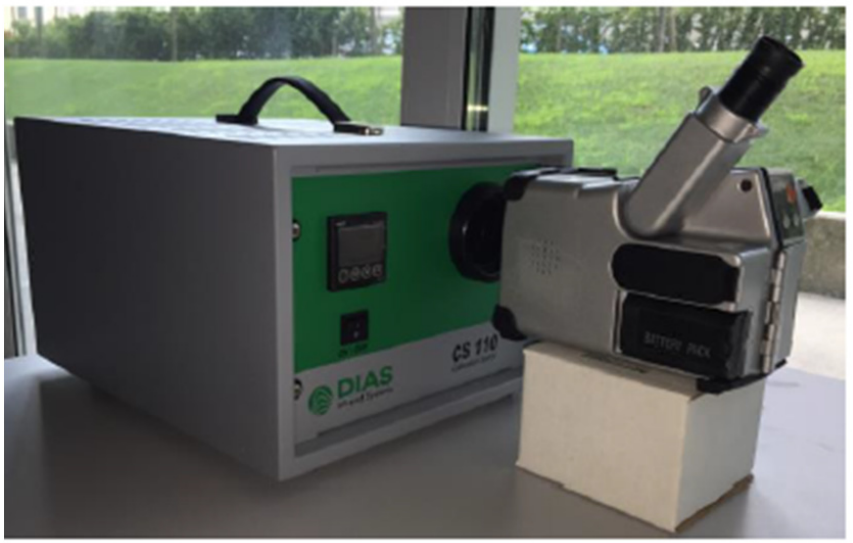
Figure 5. Calibration setup with relative positioning between the camera and the calibration body.